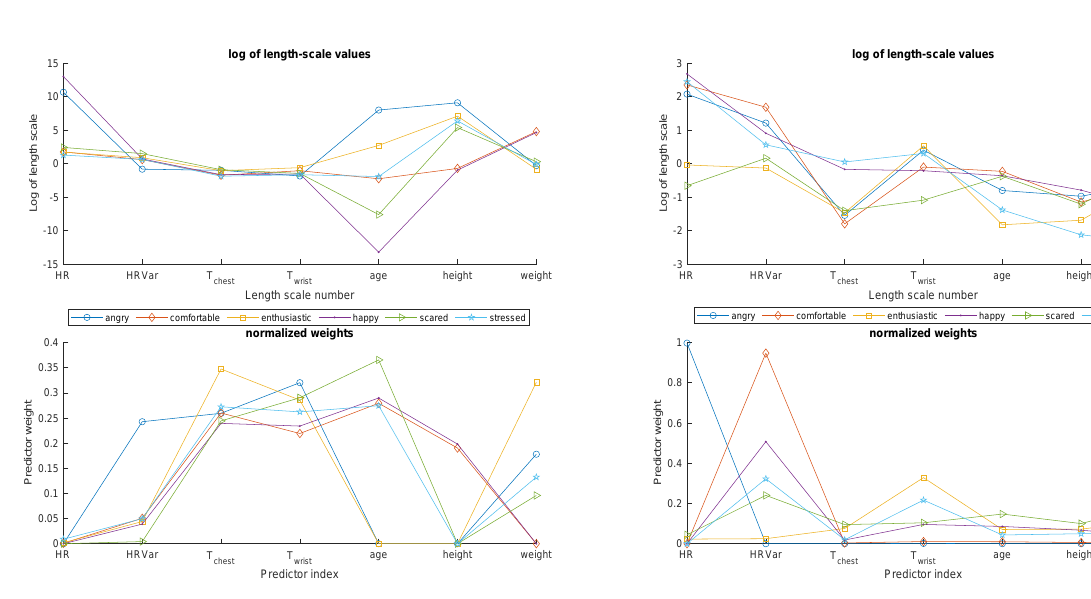
Figure 6. SE length scale parameters (log values) and parameter weights for the data set without SCL.